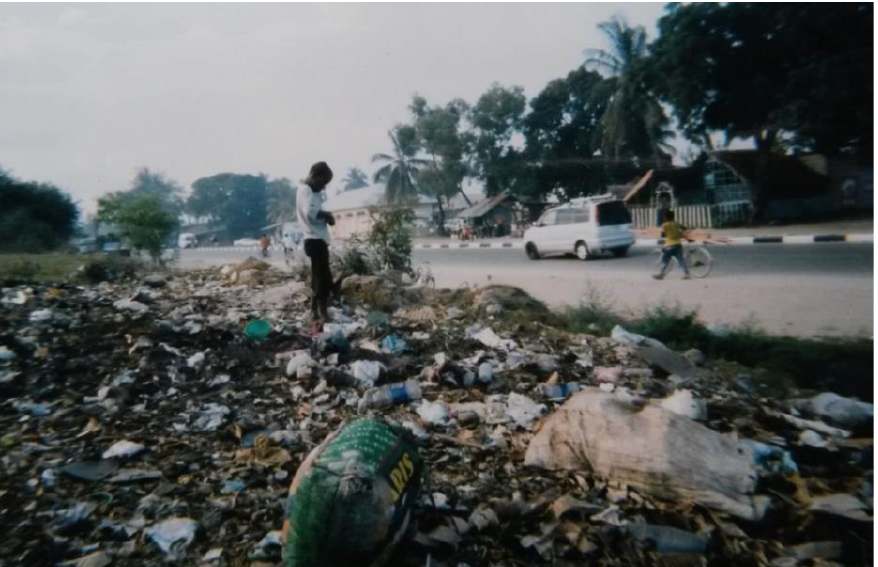
Figure 5. ‘This photo explains the life of children who wander around in the neighbourhood. They are hungry and have nowhere to live. We should take care of them [ tuwajali ] because children are the nation of tomorrow [ taifa la kesho ]. Roaming around, they might get diseases ’ .